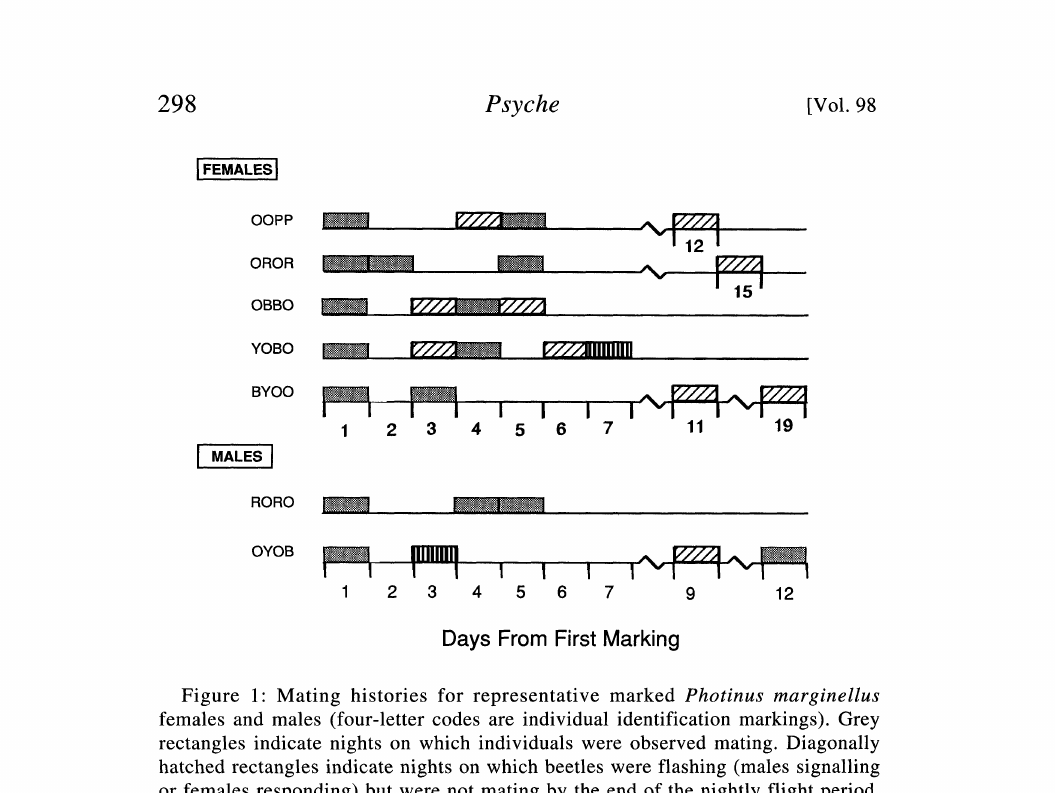
Figure 1: Mating histories for representative marked Photinus marginellus females and males (four-letter codes are individual identification markings). Grey rectangles indicate nights on which individuals were observed mating. Diagonally hatched rectangles indicate nights on which beetles were flashing (males signalling or females responding) but were not mating by the end of the nightly flight period. Rectangles with vertical bars indicate repeated stage copulation, without proceed- ing to stage